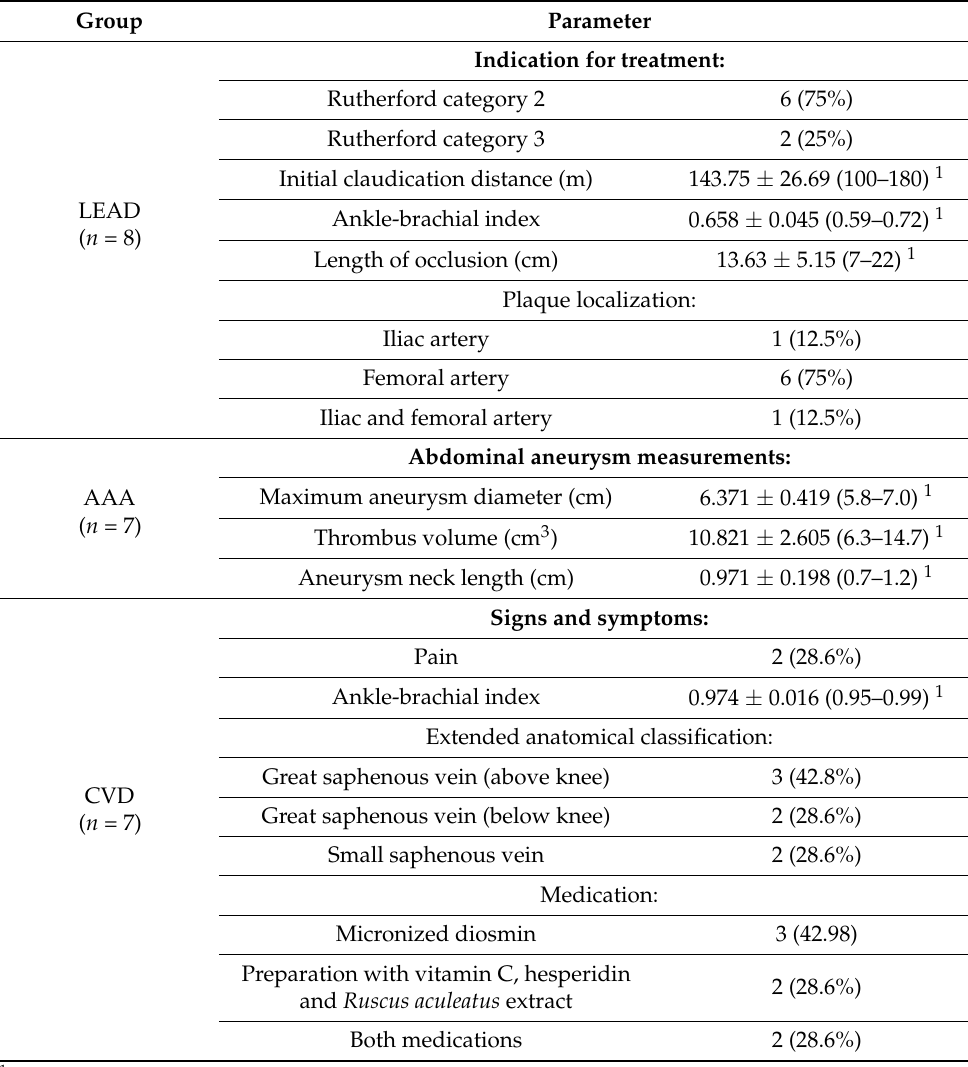
Table A1. Detailed clinical characteristics of the study subjects specific for LEAD, AAA and CVD